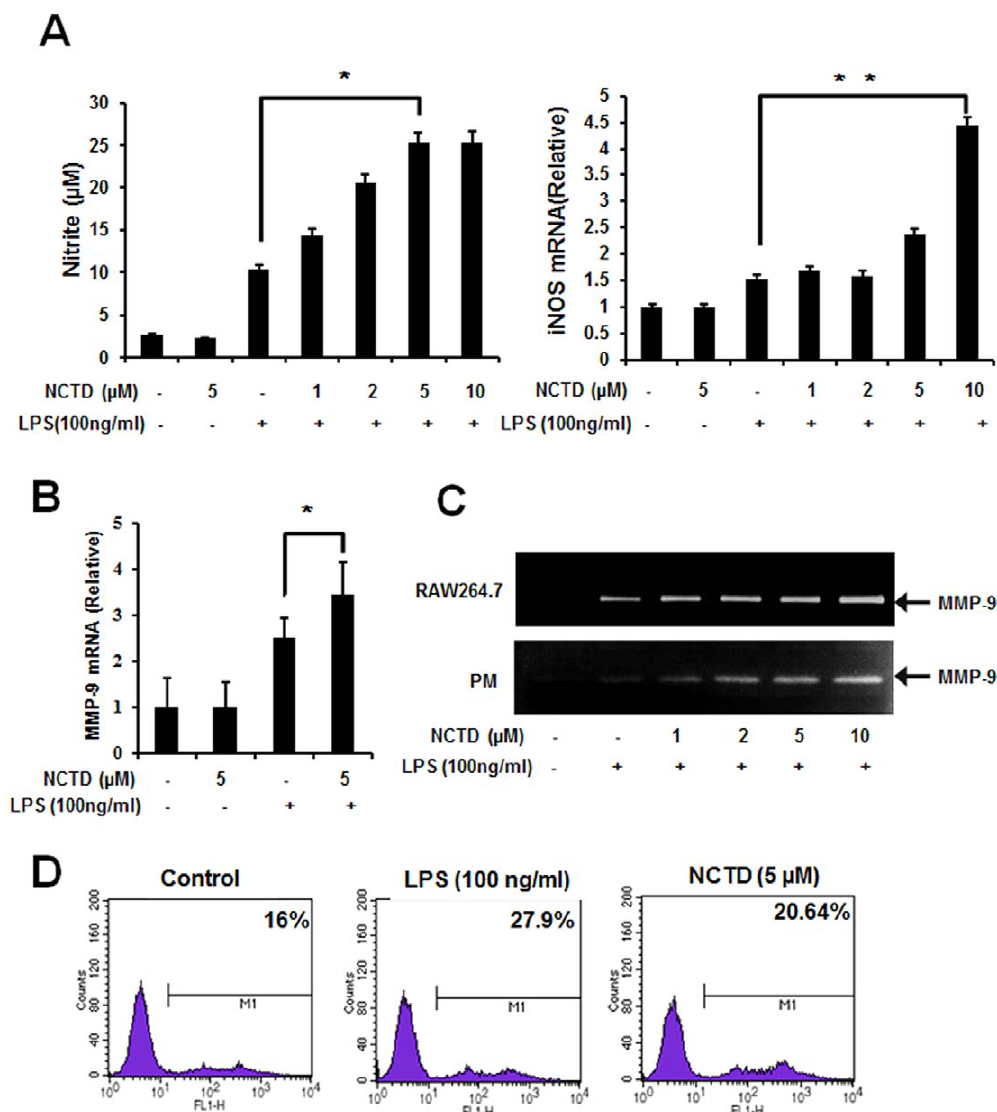
Figure 4. NO production, MMP-9 expression and phagocytosis was improved by NCTD significantly. A, NCTD increases LPS-induced NO production in macrophages. Macrophages were pretreated with PBS (containing 0.1% DMSO), 5 m M NCTD without stimulation or 1–10 m M NCTD stimulated with LPS (100 ng/ml) for 20 h, and then the production of nitric oxide was measured by Griess reaction (left). The mRNA levels of iNOS were assessed by Real time PCR (right). B, NCTD increases LPS-induced MMP-9 expression in mRNA level. RAW264.7 cells were pretreated with PBS (containing 0.1% DMSO) or 5 m M NCTD for 24 h and then stimulated with or without LPS (100 ng/ml) for 1 h. Total cellular RNAs were collected and subjected to Real time PCR analysis. C, NCTD enhances MMP-9 enzyme activity in RAW 264.7 and peritoneal macrophages. RAW264.7 cells and peritoneal macrophages were pretreated with PBS (containing 0.1% DMSO) or 1–10 m M NCTD for 12 h and then activated with LPS for another 12 h. The culture supernatants were then collected and MMP-9 levels were analyzed using gelatin zymography. D, NCTD facilitates phagocytosis of bacteria in macrophages. RAW 264.7 were pretreated with PBS (containing 0.1% DMSO), NCTD (5 m M) or NCTD with LPS (100 ng/ml) for 24 h, and then exposed to GFP-labeled E.coli for 30 min. The fluorescence were detected by flow cytometry after the cells were washed severely by ice cold PBS for three times. The numbers represent mean fluorescence intensity.